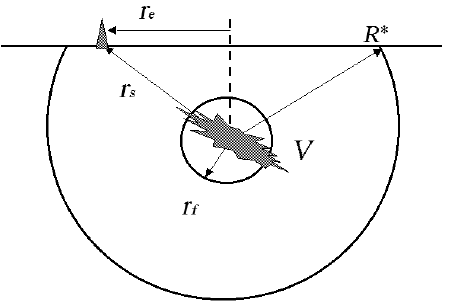
Fig. 2. A schematic layout of the earthquake nucle- ation zone: R * is the ultimate distance of the prepara- tion zone; r f is the radius of the seismic source; r e is the epicentral distance from the point of measurement; r s is the hypocentral distance, and V is the source volume.